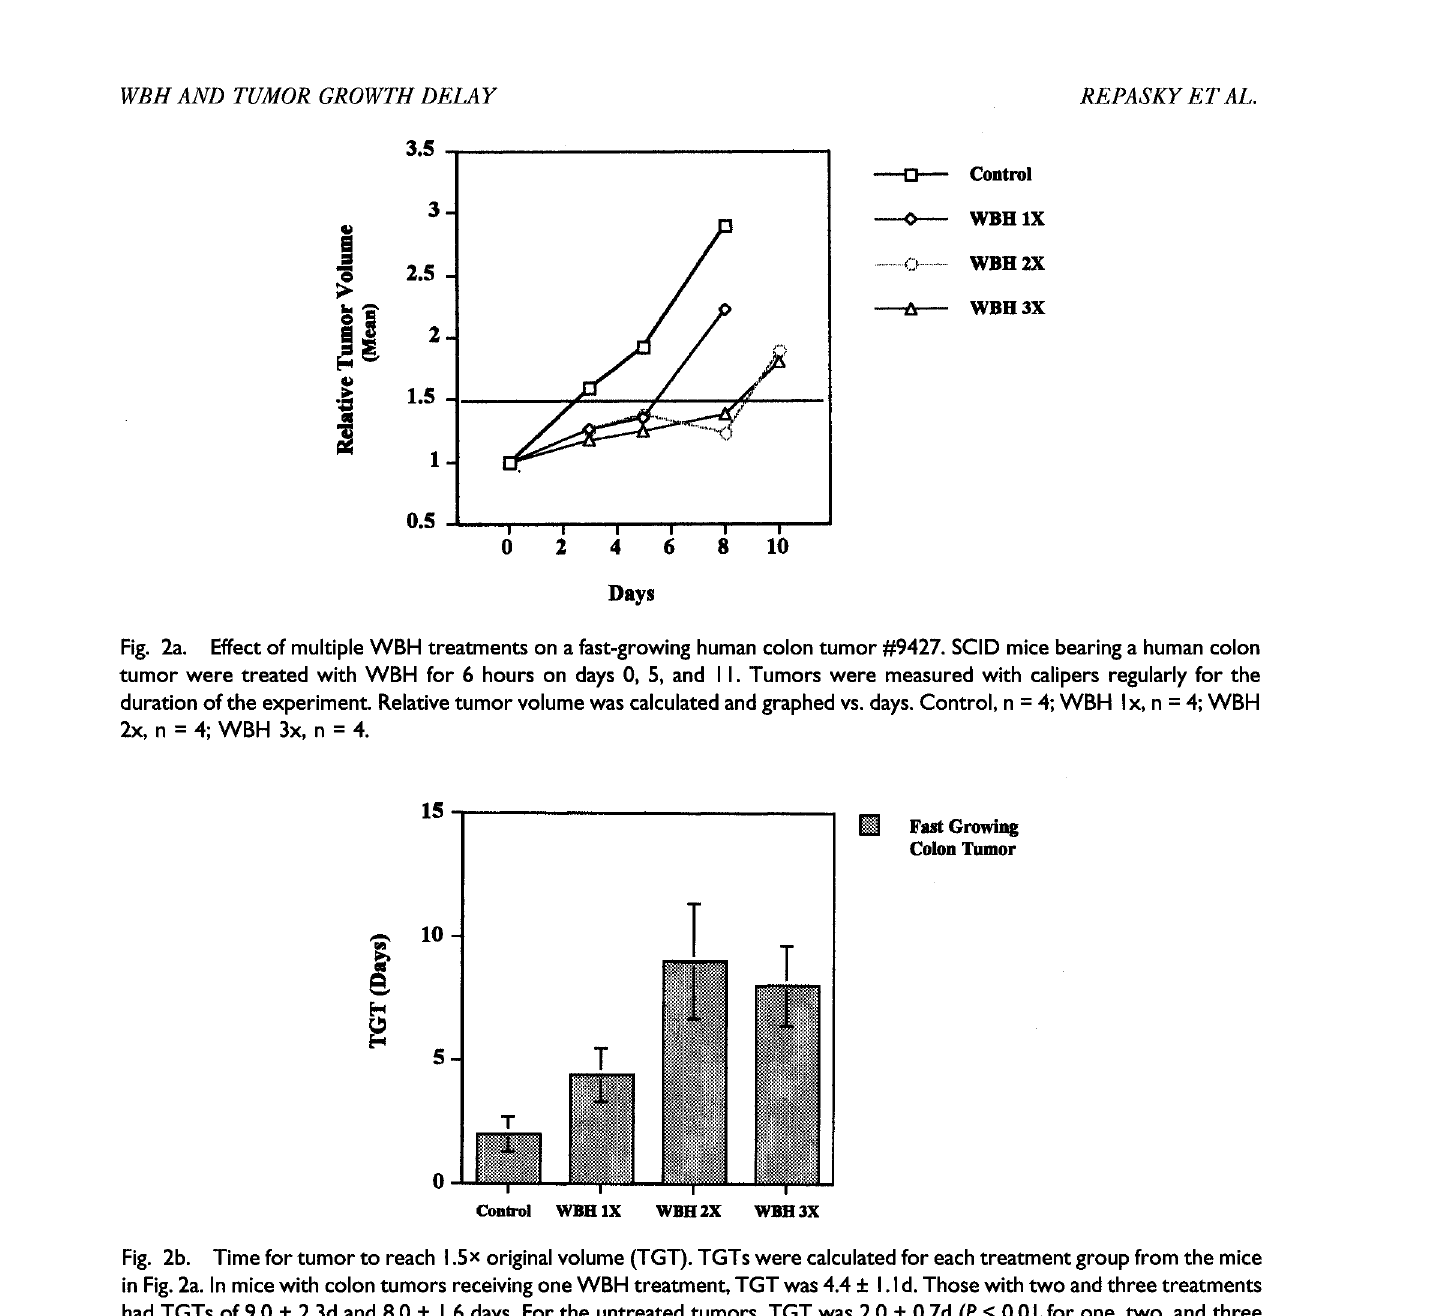
Fig. 2b. Time for tumor to reach 1.5x original volume (TGT). TGTs were calculated for each treatment group from the mice in Fig. 2a. In mice with colon tumors receiving one WBH treatment, TGT was 4.4 + I. d. Those with two and three treatments had TGTs of 9.0 + 2.3d and 8.0 + 1.6 days. For the untreated tumors, TGT was 2.0 + 0.7d (P < 0.01 for one, two, and three treatments when compared with the control; Student